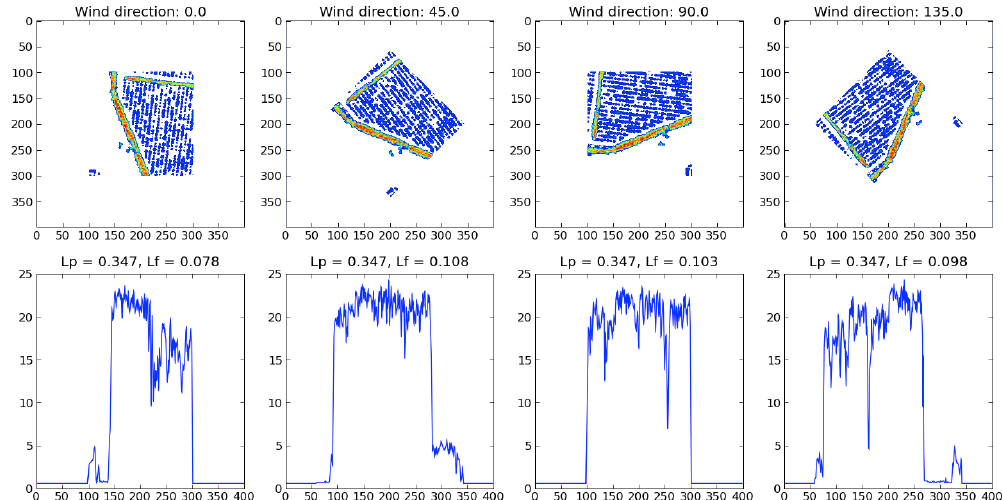
Fig. 3. A 100 × 100m subset covered with field crops and tree hedges is presented to illustrate the results of a geometrical processing. The four images at the top present the same scene considered from four different view angles, corresponding to wind directions of 0 ◦ , 45 ◦ , 90 ◦ and 135 ◦ (from North). The colours express the vegetation height from 60cm (blue) to 25m (red), and the tick marks are pixel coordinates. The four bottom images illustrate the frontal area of this subset from each of the four orientations of the wind. Abscissa marks are pixel coordinates, while the ordinate marks represent the obstacle height in meters. In this figure, Lp refers to the plan area index, and Lf to the frontal area index.